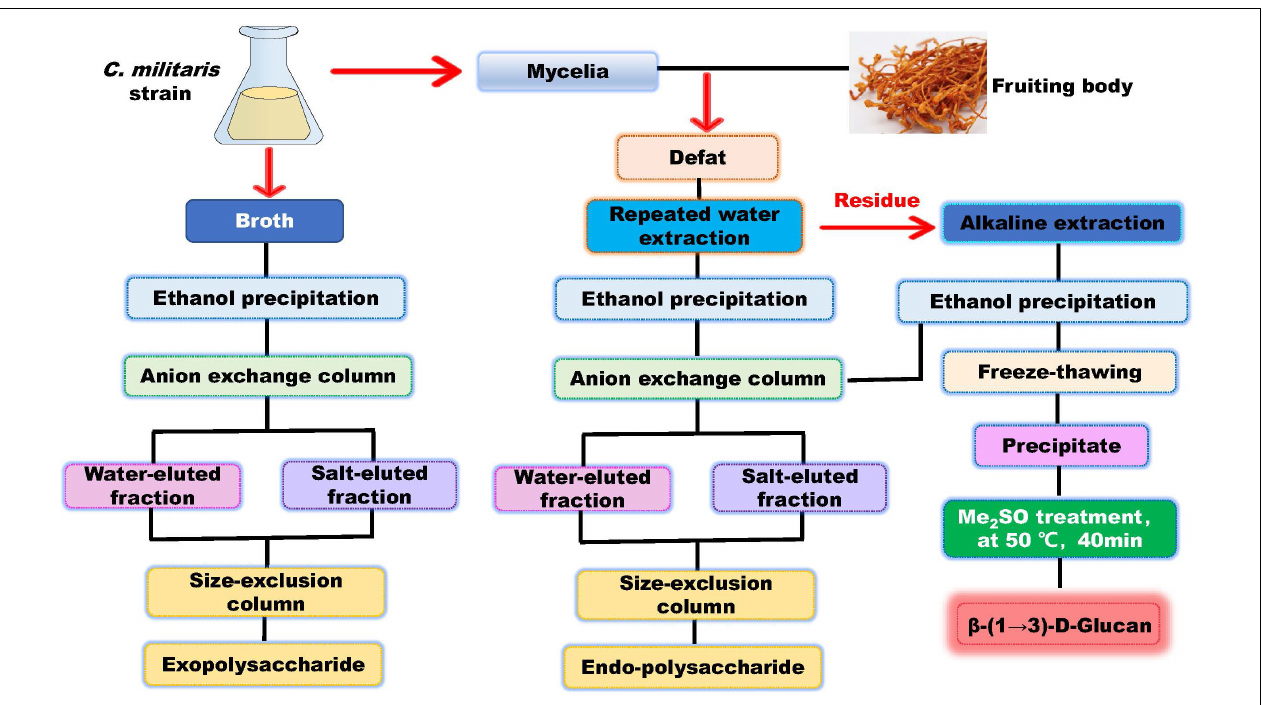
FIGURE 4 | Scheme for Extraction and Purification of C. Militaris -Derived